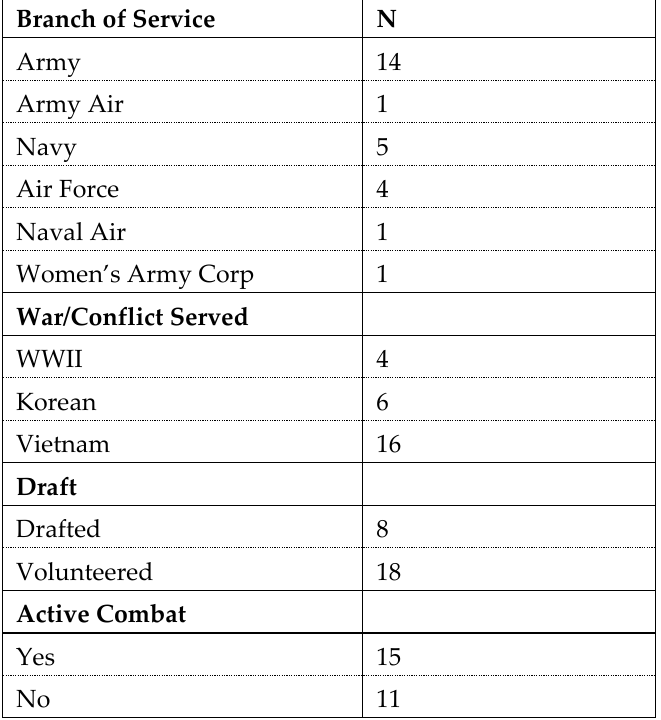
Table 1: Descriptive Characteristics of Veterans